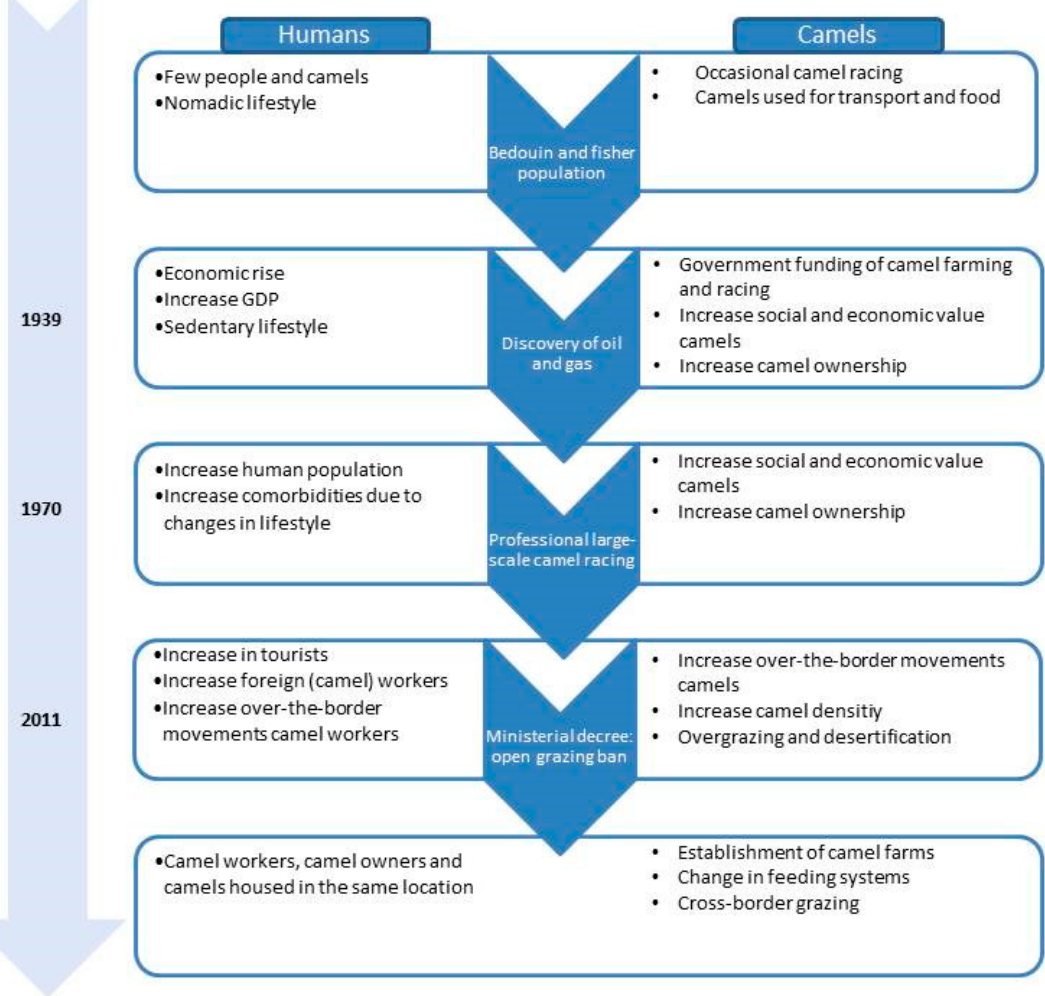
Figure 5. Visual summary/timeline of relevant events.